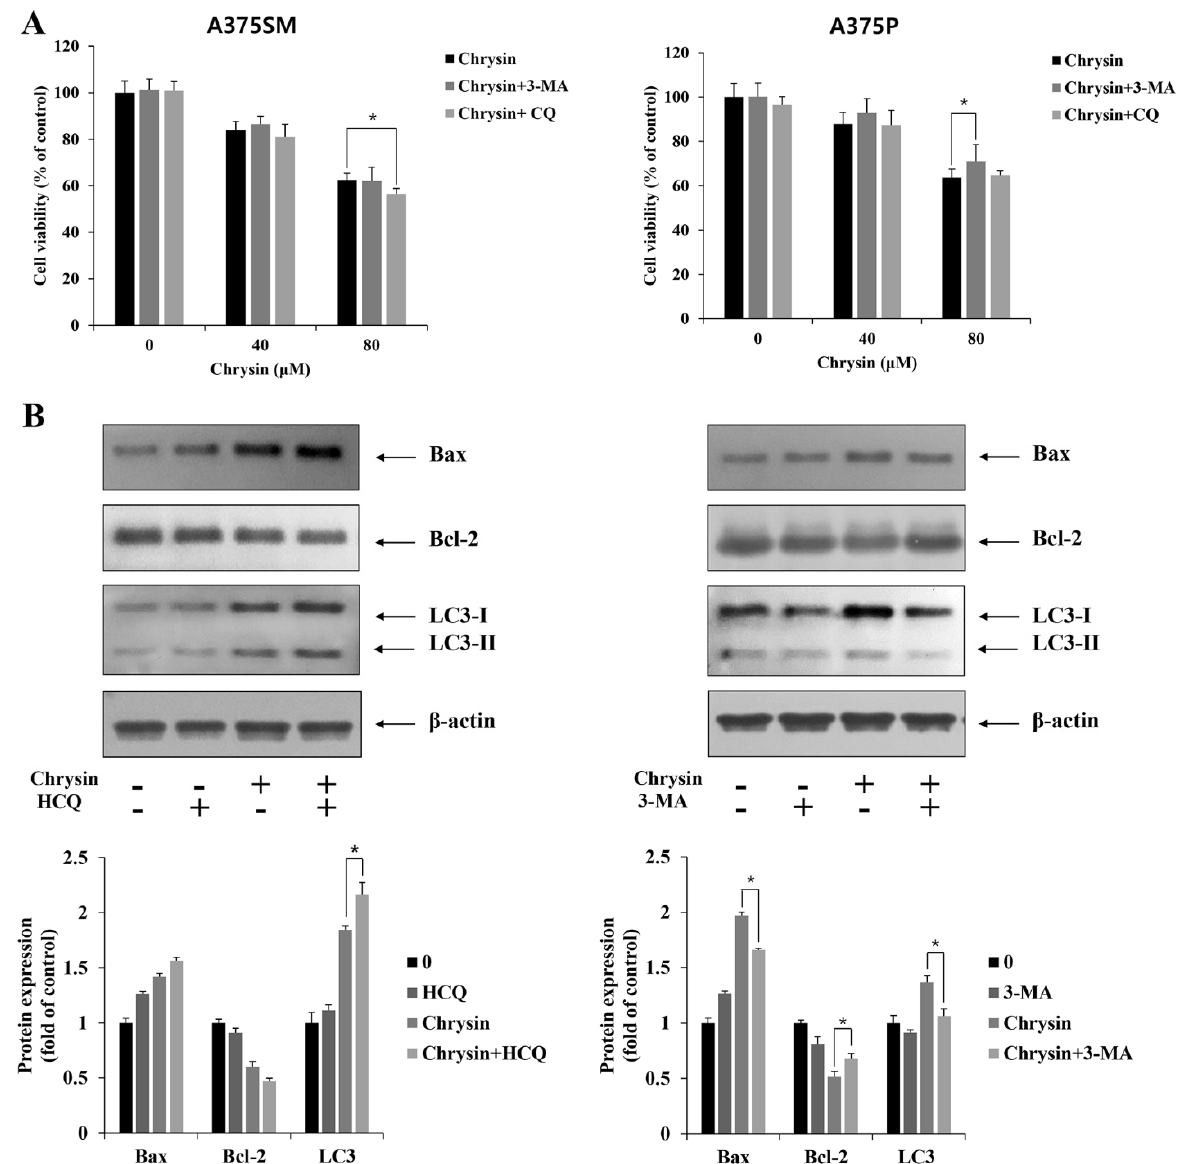
Figure 7. Chrysin induced cell death or cell-protective autophagy in A375SM and A375P human melanoma cancer cells. Cells were pretreated with hydroxychloroquine (HCQ, 25 µM, 2 h) or 3 − methyladenine (3 − MA, 2 mM, 1 h) and subsequently treated with indicated concentrations of chrysin for 24 h. ( A ) Cell viability was measured by MTT assay. ( B ) Protein levels of Bax, Bcl − 2, and LC3 were measured by Western blotting. β − actin was used as a loading control. Quantification was performed in three independent experiments using ImageJ, normalizing the intensities of the bands to the controls. Data are presented as the mean and standard deviation for three samples. Significance was determined by Student’s t -test, * p < 0.05, compared with the